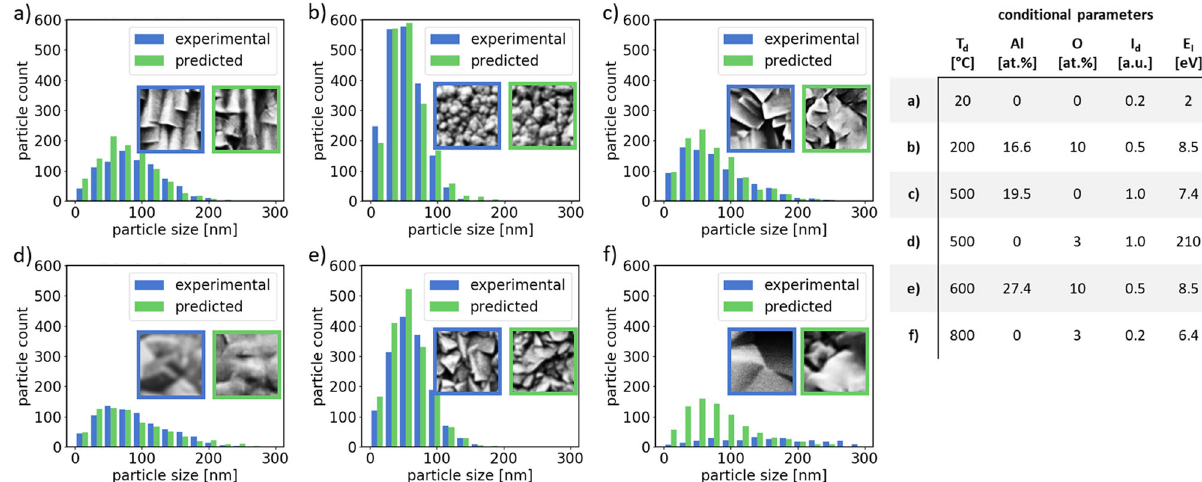
Fig. 3 Evaluation of predicted microstructures. Particle size distributions and examples of SEM surface microstructure images (blue frame) and cGAN- generated images (green frame) of the training set for the same conditional parameters; results are shown for a a Cr – N fi lm deposited without intentional heating; b , e Cr – Al – O – N fi lms with 10 at.% O-contamination, deposited at 200 and 600 °C, respectively; c a Cr – Al – N thin fi lm deposited at 500 °C; d , f Cr – O – N fi lms with 3 at.% O-contamination that were deposited at 500 and 800 °C, respectively. The conditional parameters of the shown images are summarized in the